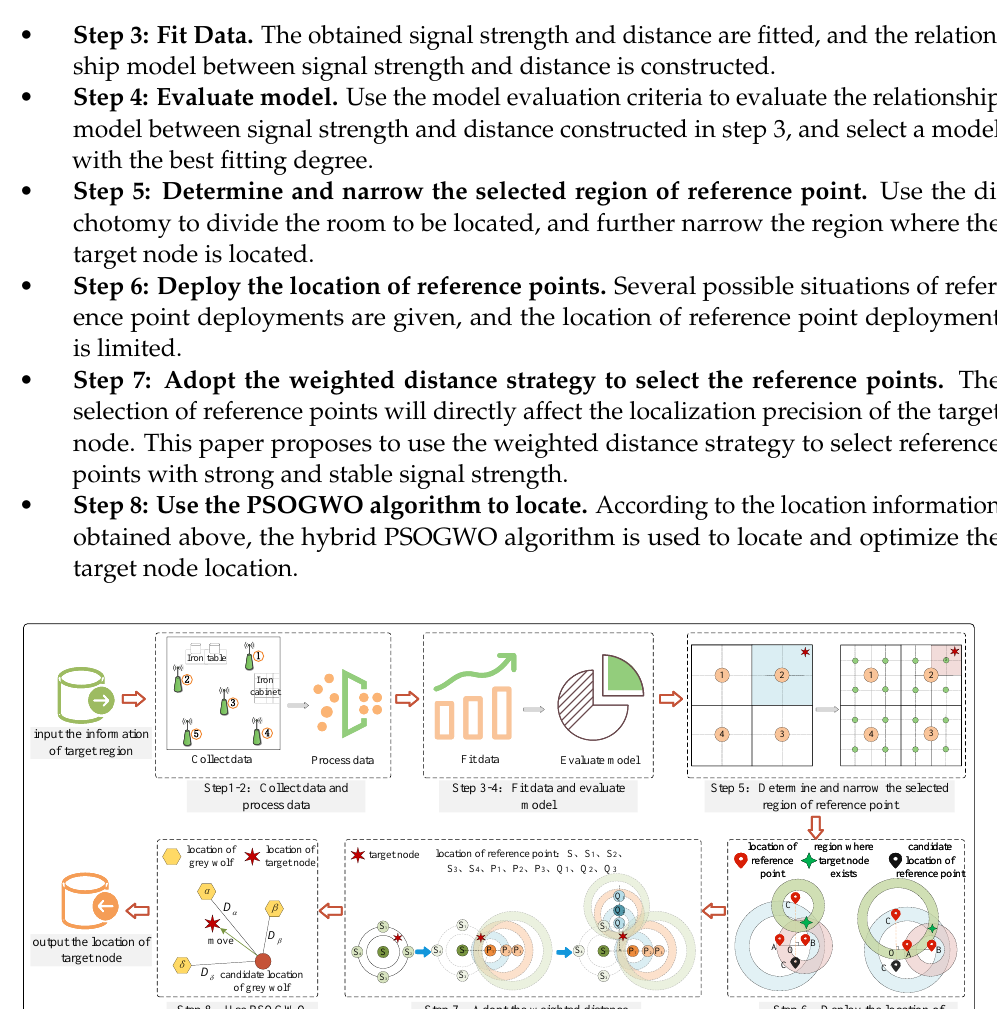
Figure 1. The basic principle framework of the